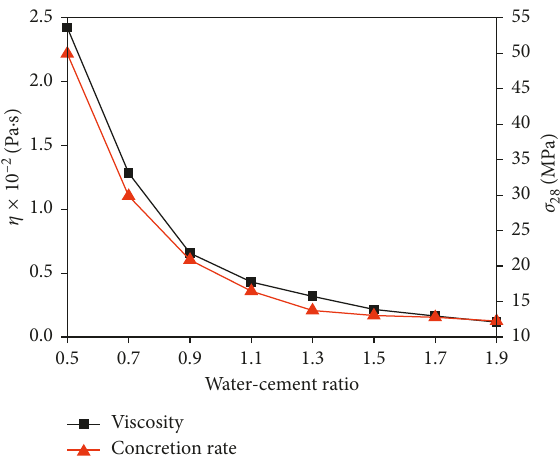
Figure 1: Grain size mixture of the crushed coal sample prepared for the grouting tests. Figure 2: Viscosity and the strength of 28 days of curing for the grouts versus water-cement